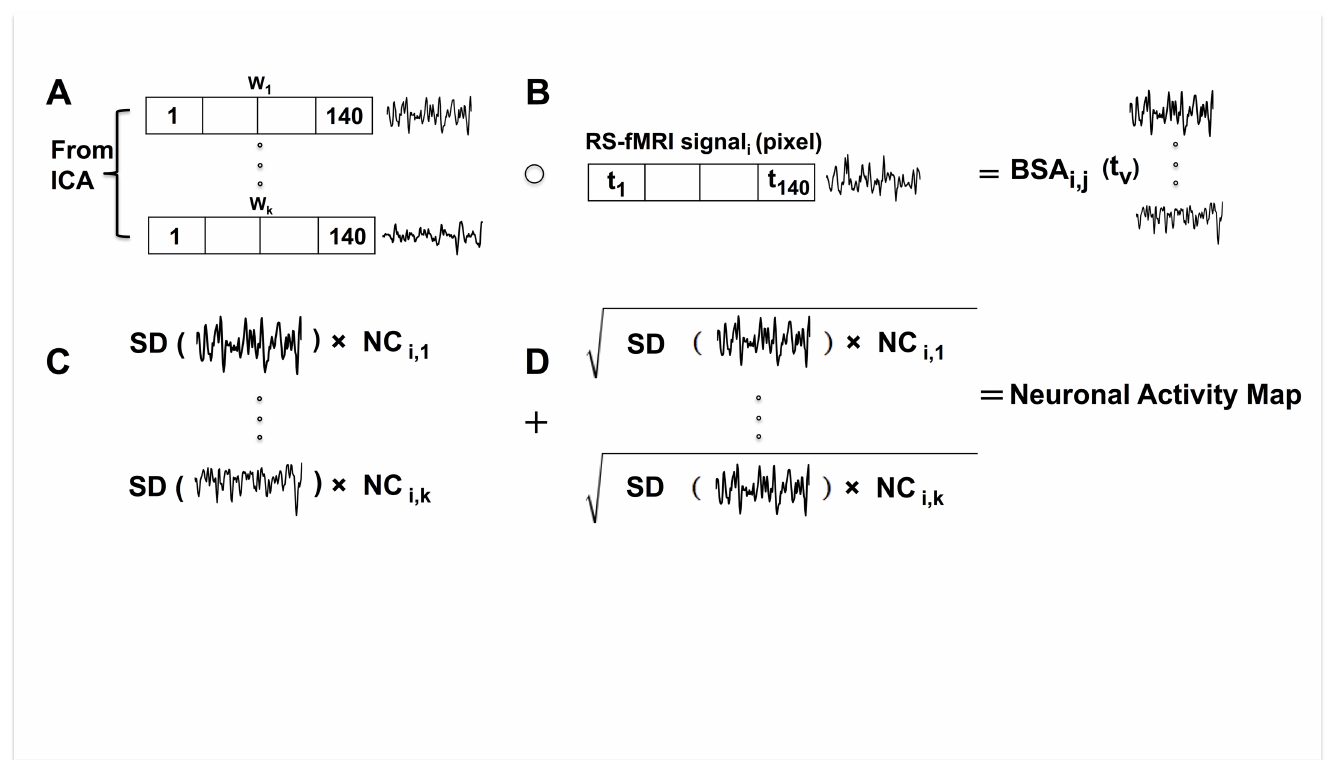
Fig 1. Schematic diagram of the brain activity metric calculated from the RS-fMRI signal in one pixel. The signal shown is a graphical representation of the vector data. (A) Neuronal time courses ( W ) are definedby the ICA and verifiedusing a goodness of fit calculation, multipletemplate matchingmethod and a support vector machineclassifier. (B) The Hadamard product of each neuronal time course is taken with the RS-fMRI signal.(C) The standard deviationof the resultingsignalis multiplied by the neuronalcomponent.(D) The square root of the contributionof each neuronaltime course is added to create a measureof